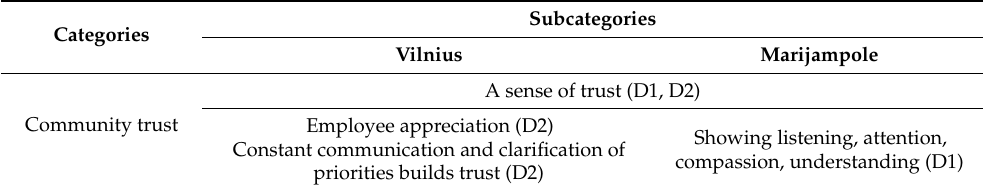
Table 7. Signs of community trust in the